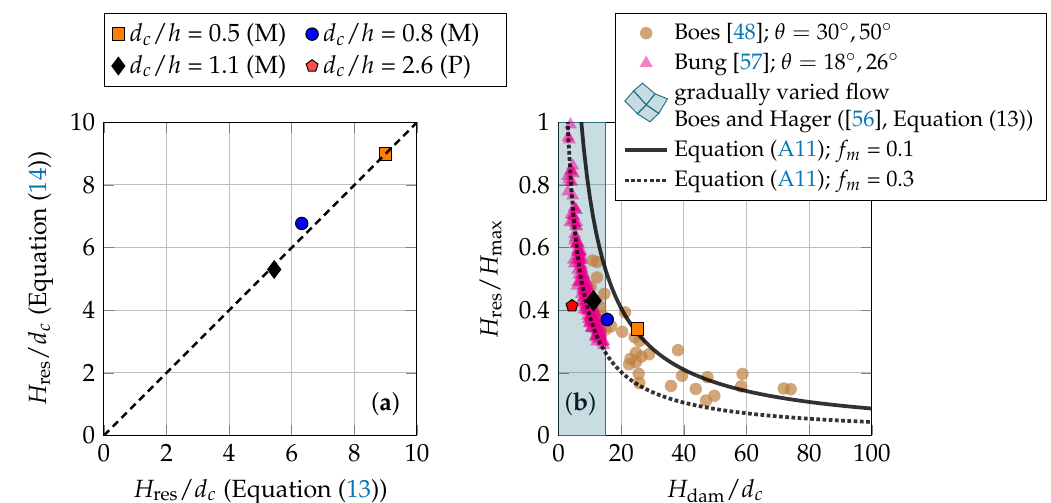
Figure 9. Residual energy ( H res ) at the downstream end of the stepped spillway chutes ( a ) laboratory experiments: H res computed using air–water flow properties (Equation (13)) versus the remote sensing methodology (Equation (14)) ( b ) residual energy of the present study (laboratory + prototype) compared with literature data